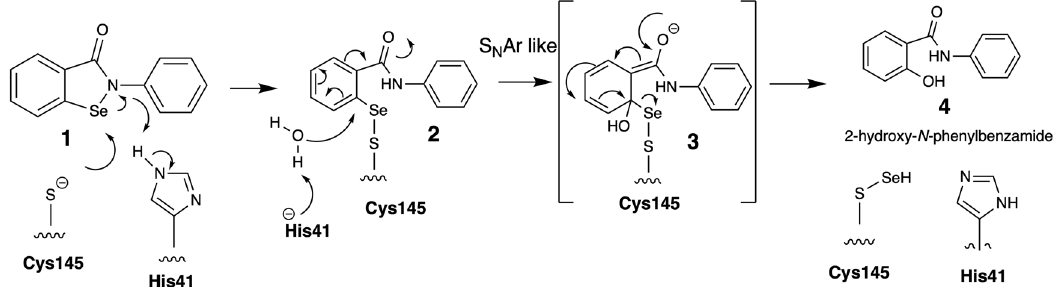
Fig. 4 Chemical mechanism for selenation of M pro cysteine 145 by ebselen. His41 assists a water-mediated attack on intermediate 2 leading to a hydrolysis reaction akin to peptide hydrolysis leading to the generation of the hydrolysis product 4